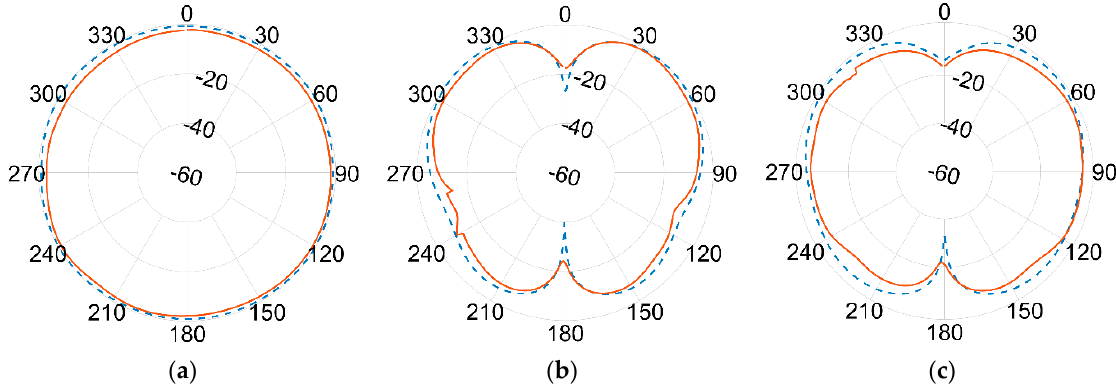
Figure 19. Normalized gain pattern of the aluminium prototype at 1.09 GHz, ( a ) XY plane, ( b ) XZ plane, and ( c ) YZ plane—Simulated (blue dashed line) and Measured (red line) data in dB.